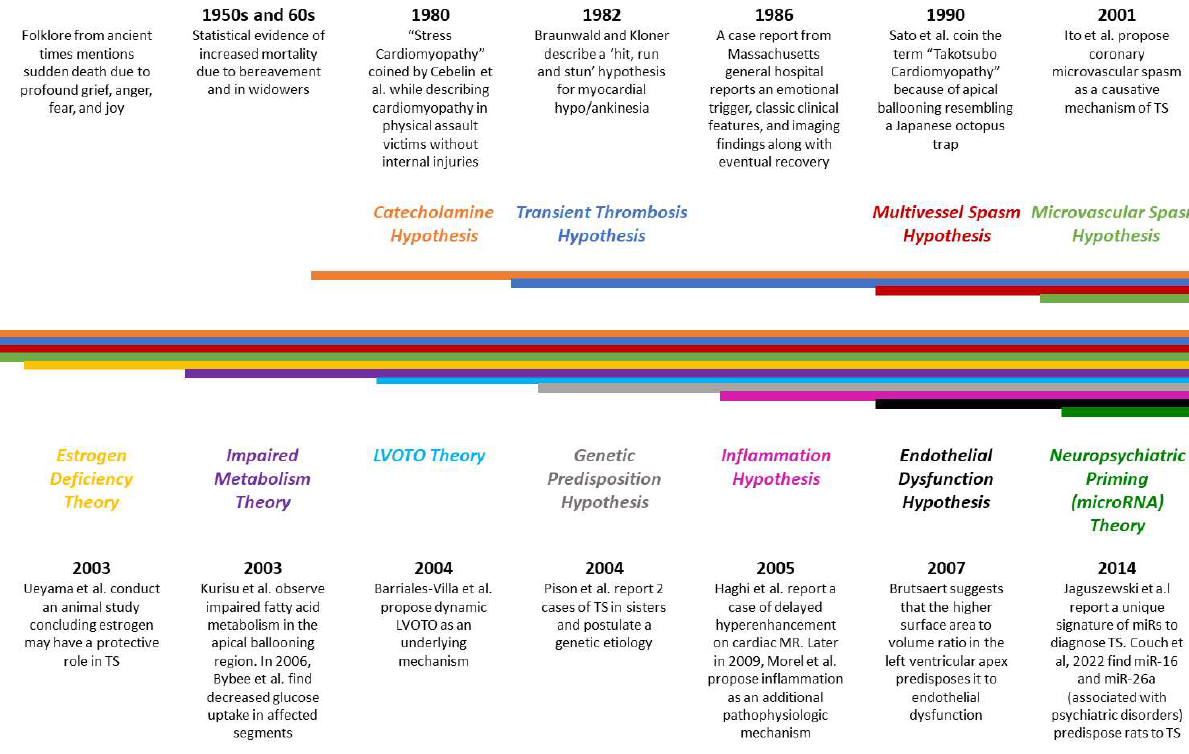
Figure 1. Timeline—showing the landmark research developments over the years for Broken Heart Syndrome [12,13,16,19–31].